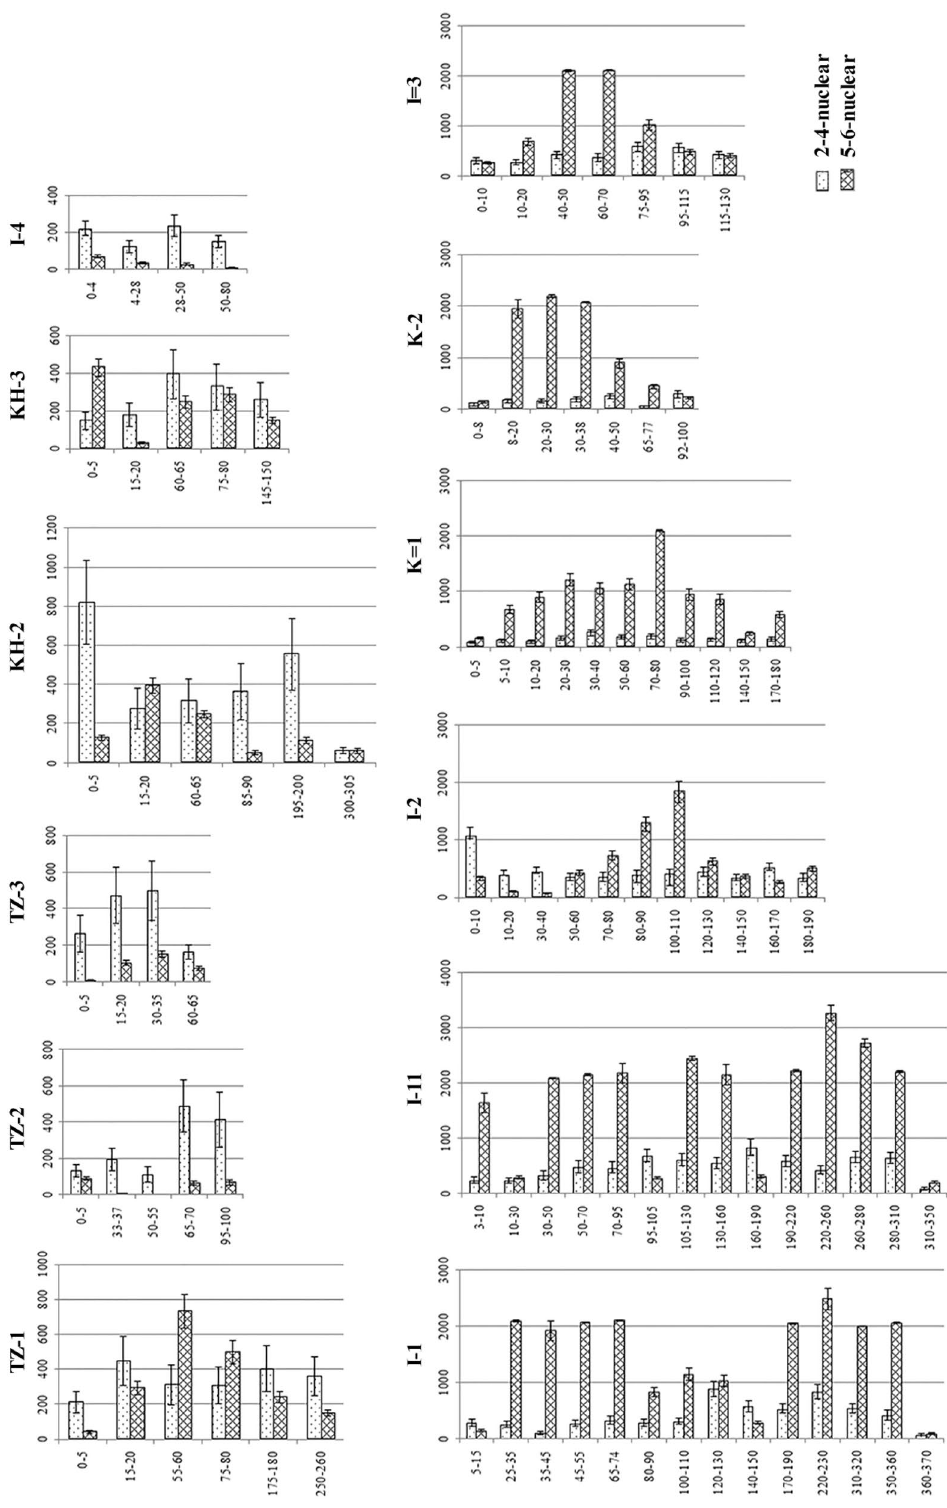
Figure 3. Distribution of low molecular weight (light) and high molecular weight (heavy) PAHs in peat